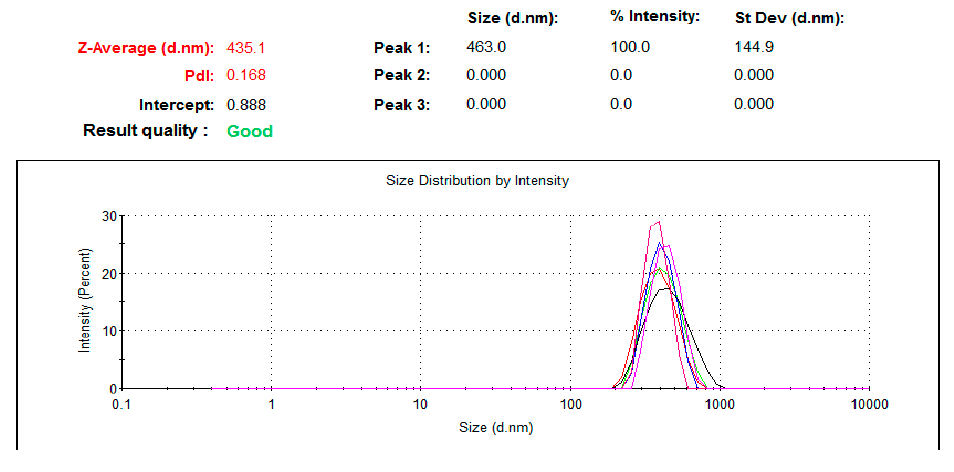
Figure 6. DLS analysis of ZnO NPs.